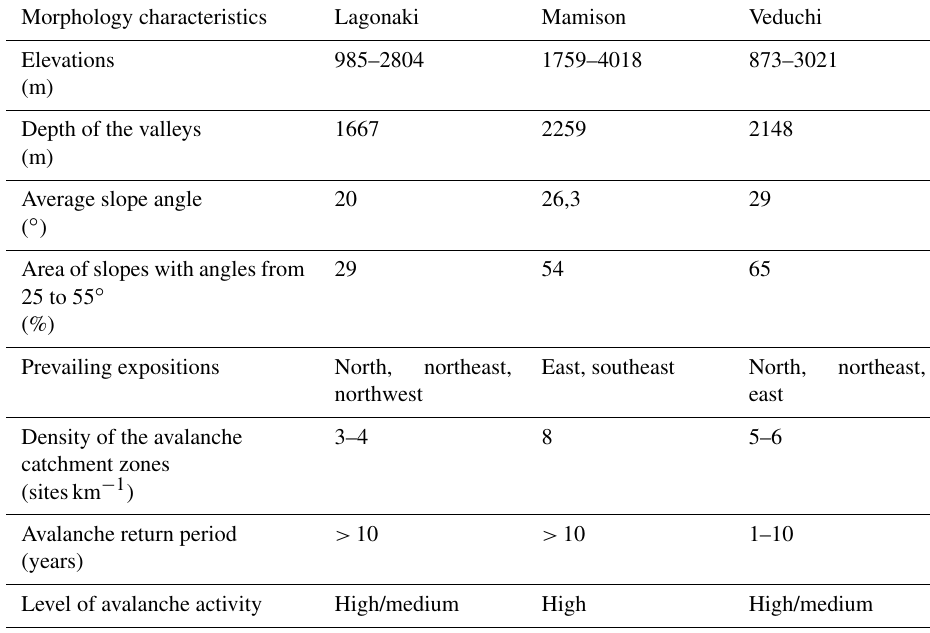
Table 2. Morphology characteristics in Lagonaki, Mamison and Veduchi regions (Komarov, 2013). Morphology